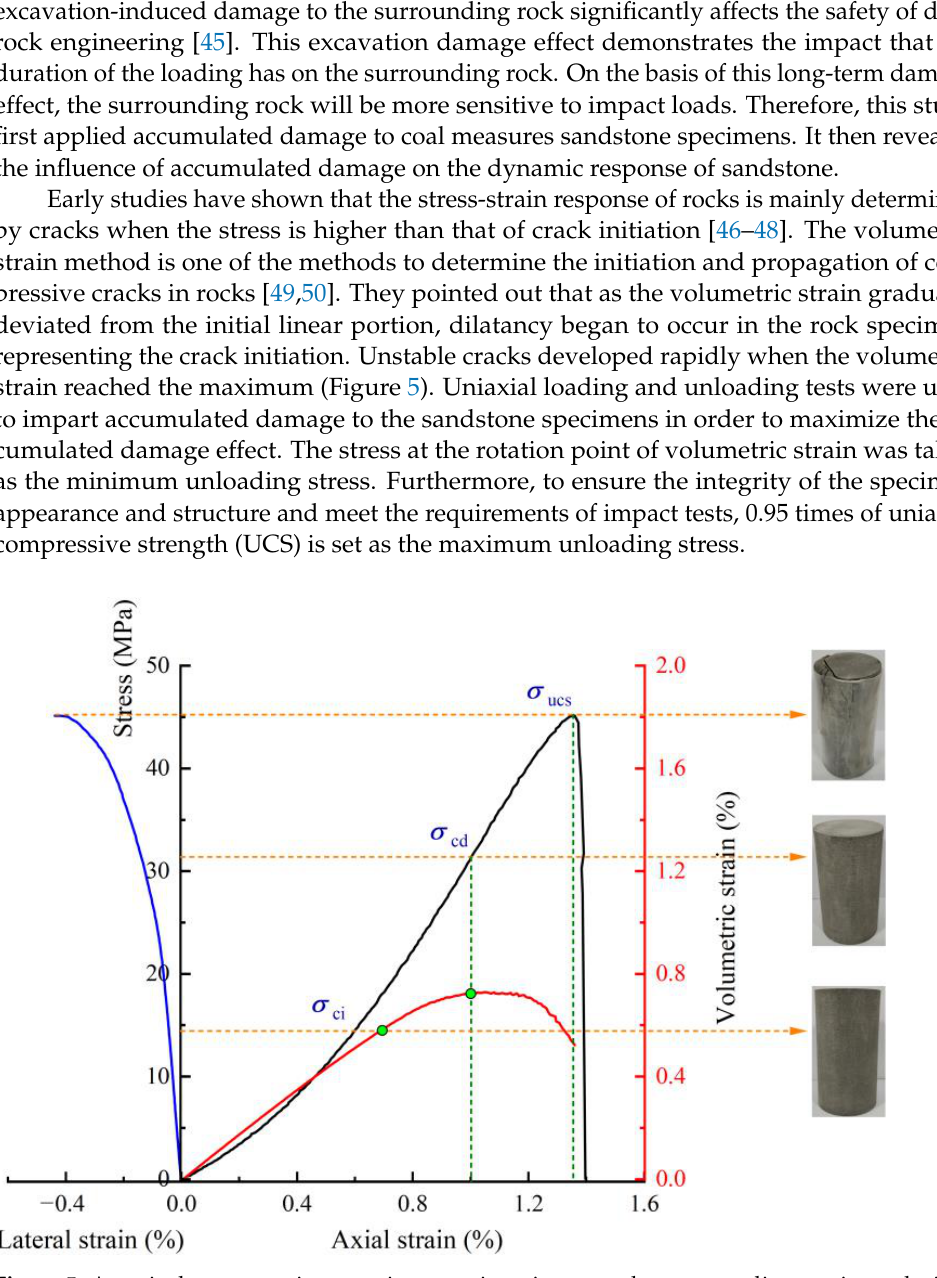
Figure 5. A typical stress-strain curve in a quasi-static test and corresponding strain evolutions (black line: the complete stress-strain curve; red line: the volumetric strain curve; blue line: the lateral strain curve).